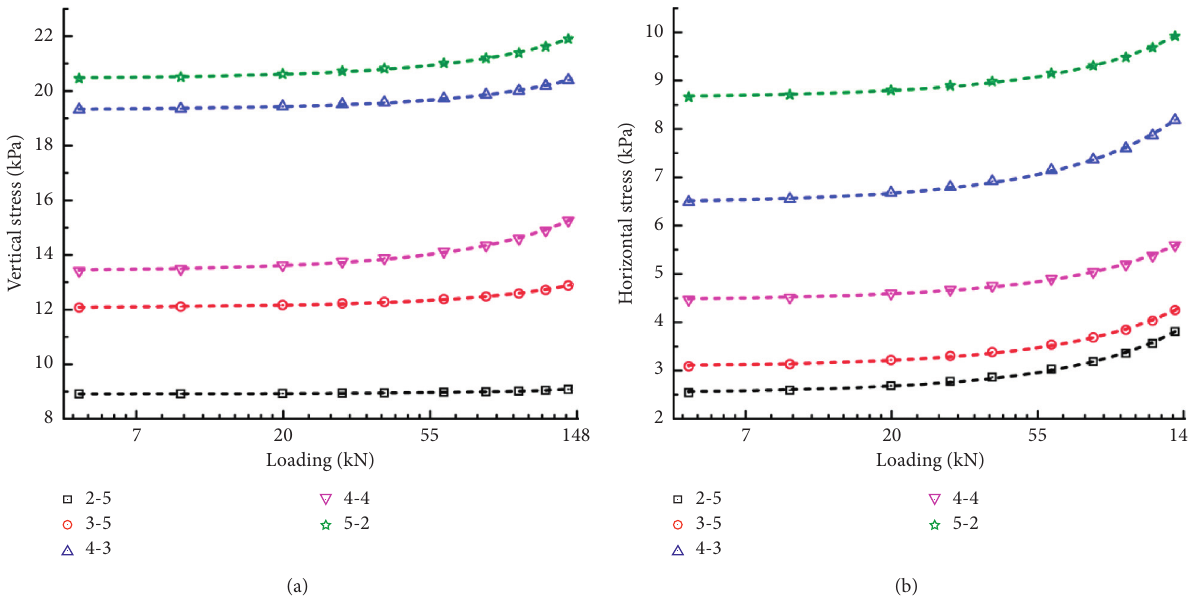
Figure 9: Relationship between the qualified stresses and loading in the free zone. (a) Vertical stress. (b) Horizontal stress.